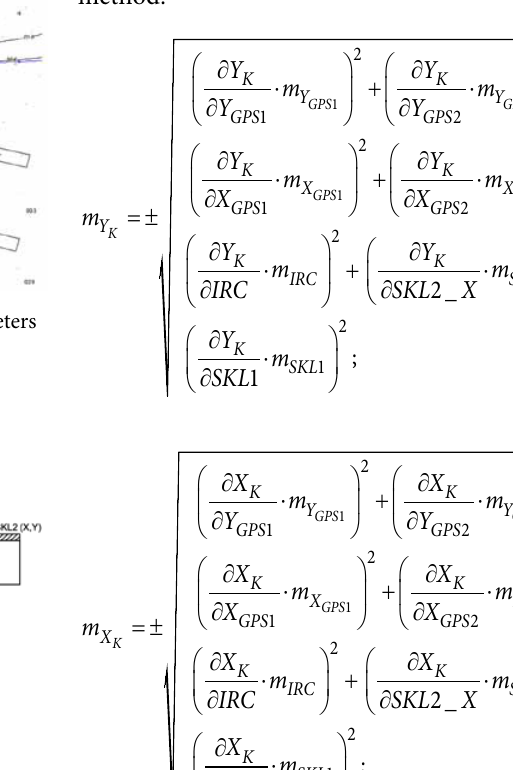
Fig. 5. Positions of GNSS and inertial sensors at the K800/103